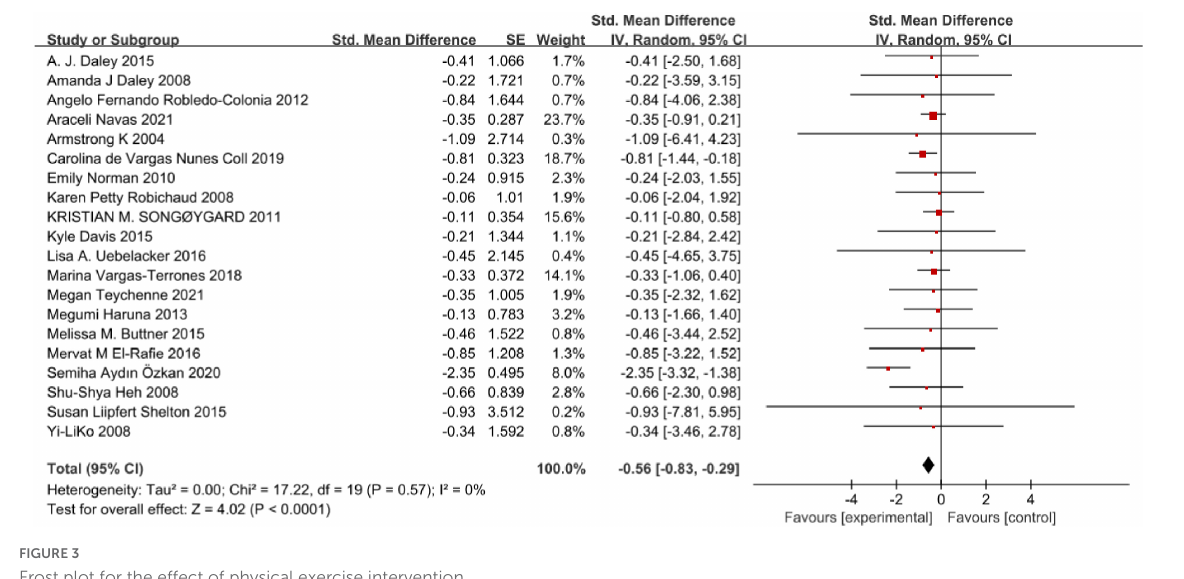
FIGURE3 Frost plot for the effect of physical exercise intervention.